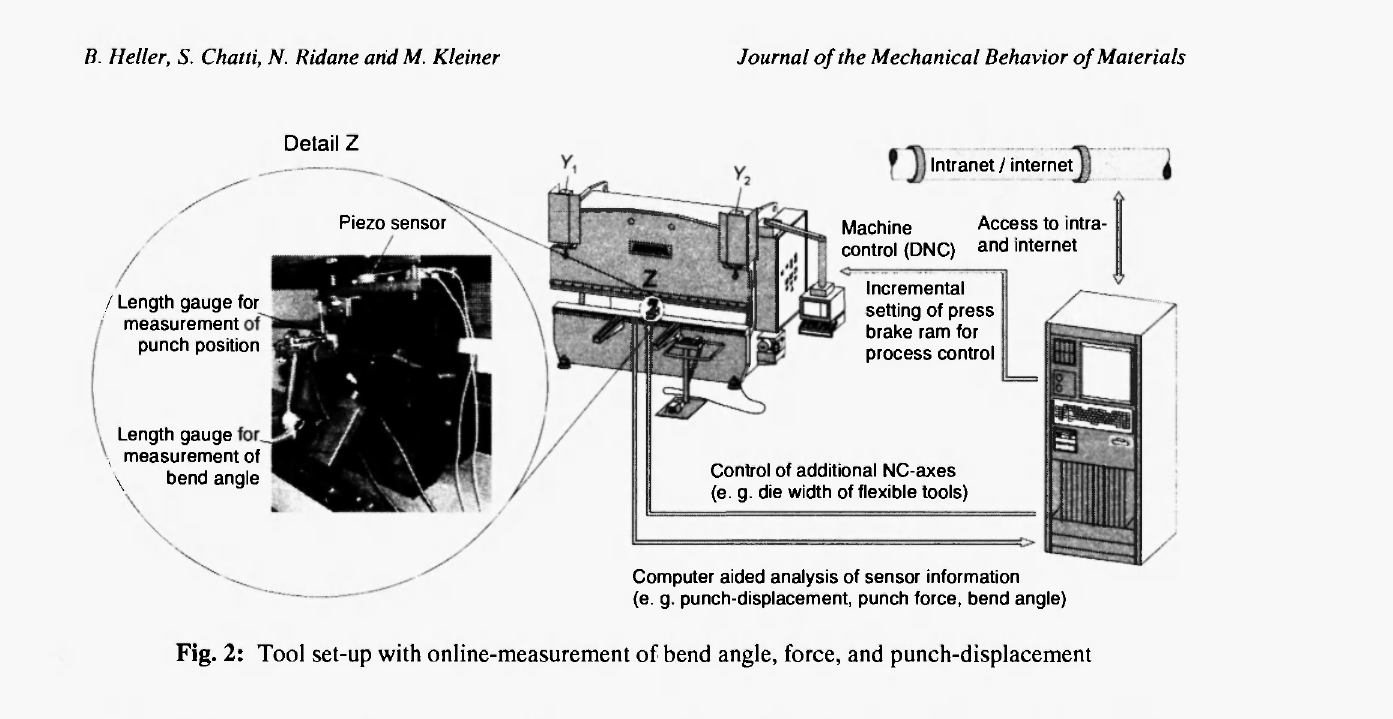
Material properties and flow curves of the investigated materials have been determined by means of standardized tensile tests /14/. Based on the material data and the approximated flow curves the process data